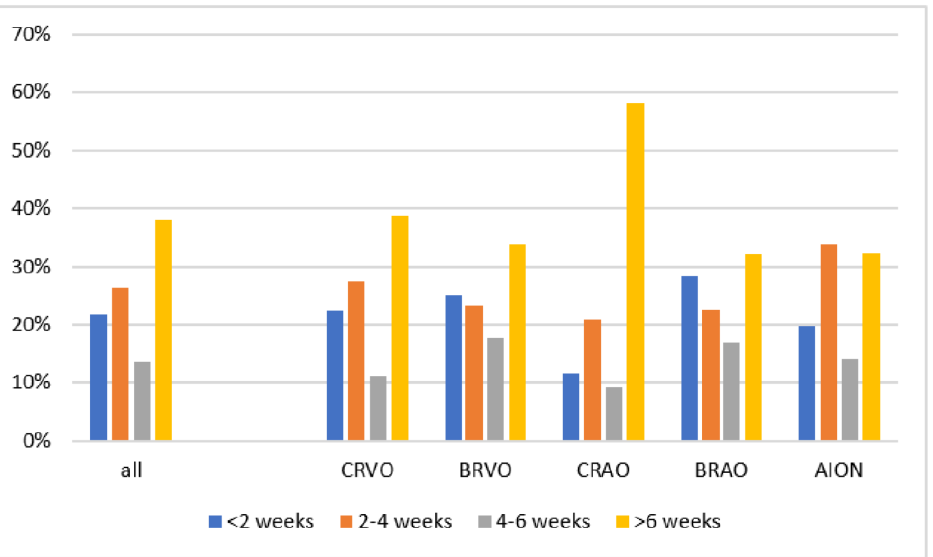
Figure 2. Frequency distribution of the time points of symptom onset after vaccination in the RVOD subgroups. CRVO = Central Retinal Vein Occlusion; BRVO = Branch Retinal Vein Occlusion; CRAO = Central Retinal Artery Occlusion; BRAO = Branch Retinal Artery Occlusion; AION = Anterior Ischaemic Optic Neuropathy.